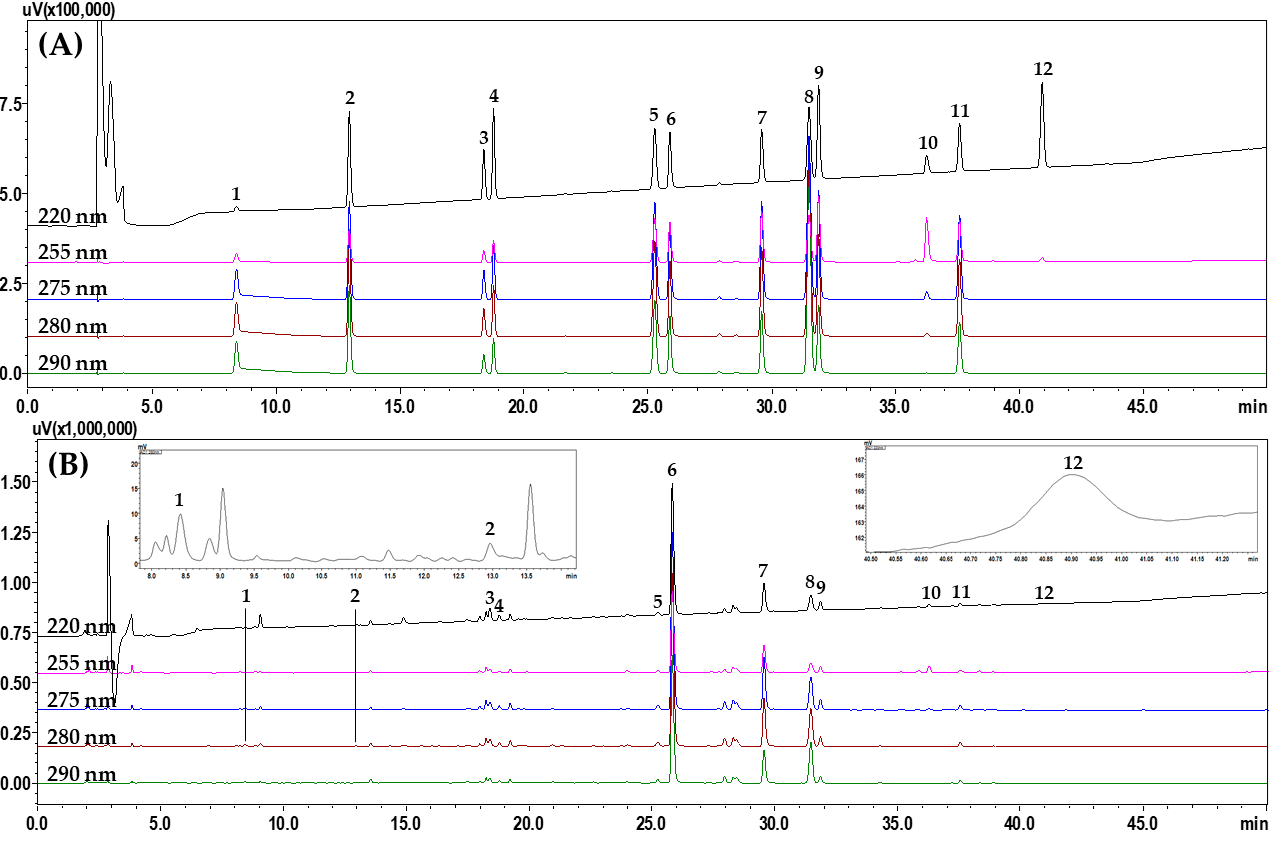
Figure 2. Representative HPLC chromatograms obtained for ( A ) standard solution and ( B ) 70% methanol extract of SRT water extract. The indicated peaks are 5-(hydroxy-methyl)furfural ( 1 ), 3,4-dihydroxybenzaldehyde ( 2 ), liquiritin apioside ( 3 ), liquiritin ( 4 ), coumarin ( 5 ), baicalin ( 6 ), wogonoside ( 7 ), cinnamaldehyde ( 8 ), baicalein ( 9 ), glycyrrhizin ( 10 ), wogonin ( 11 ), and atractylenolide III ( 12 ).